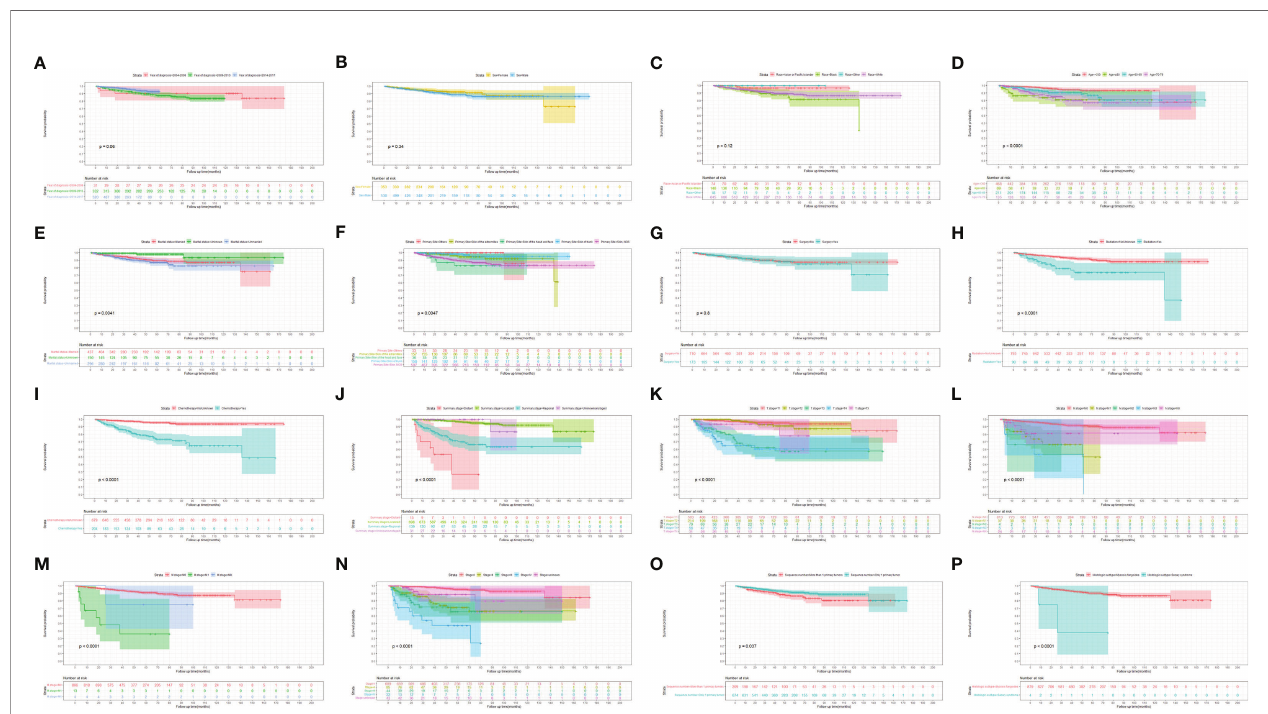
FIGURE 4 | Kaplan-Meier survival analysis of the effect of each independent predictor on DSS in patients with HIV-associated CTCL. (A – P) The survival curves of year of diagnosis, sex, race, age, marital status, primary site, surgery, radiation, chemotherapy, summary stage, t stage, n stage, m stage, stage, sequence number, histologic subtype, respectively. DSS, disease-speci fi c survival; HIV-associated CTCL, human immunode fi ciency virus associated cutaneous T-Cell